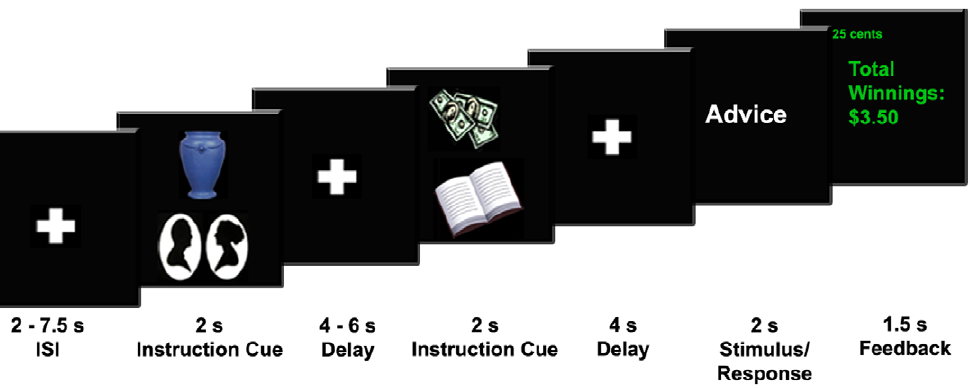
Figure 2. Trial Structure for the fMRI Experiment. After a variable duration fixation cross, an instruction cue signaled the currently relevant rules (profile of faces=male/female rule; book=abstract/concrete rule) and whether or not to expect a monetary reward (blue vase=no money; bills=25¢). This was followed by a variable duration delay period and then a word or face stimulus, during which subjects made a button response. Finally, a screen revealed whether money had been earned on that trial and cumulative winnings. On key trials, a second instruction cue appeared before the stimulus. Across the two instruction cues, we varied whether there was repetition of the rules, expected reward, both, or neither. suppression in the left inferior frontal gyrus (IFG; pars triangula- ris), left ventral premotor cortex extending into the posterior IFG (pars opercularis), supplementary motor area, aMCC, cerebellum,